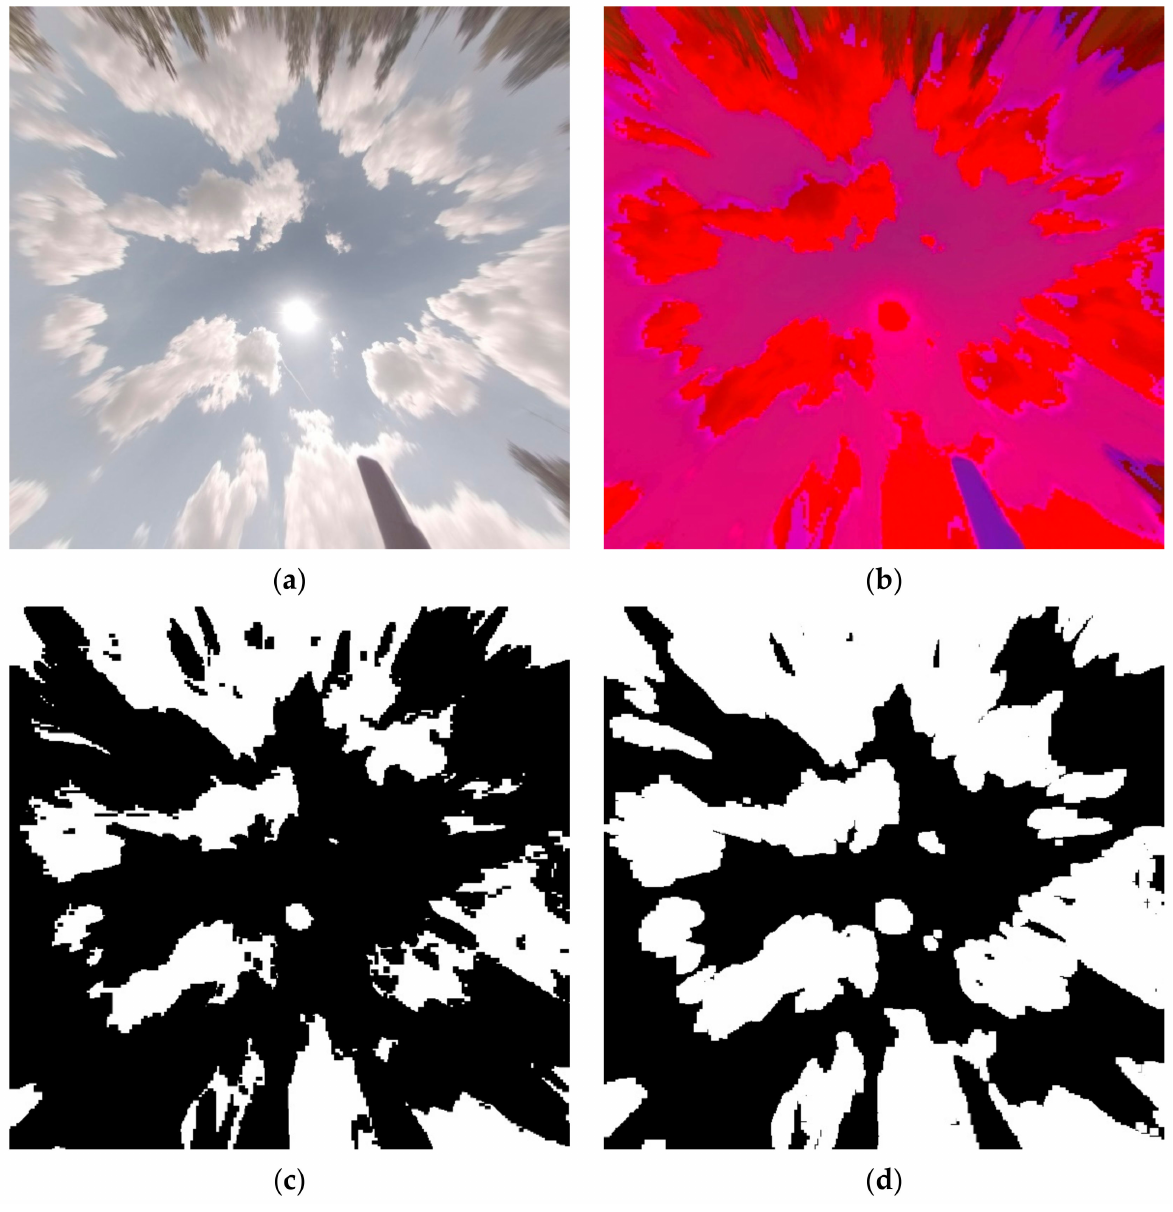
Figure 7. Image processing process for cloud detection: ( a ) original image, ( b ) HSV format of the image, ( c ) detected clouds after erosion operation, and ( d ) detected clouds after dilation